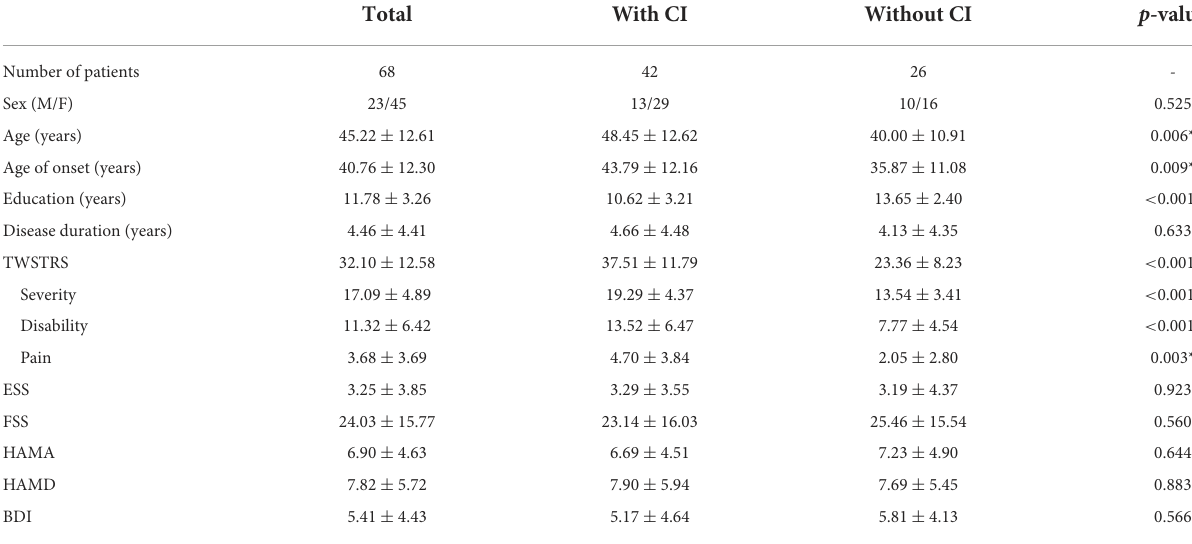
TABLE 3 Demographic and clinical data between CD patients with and without CI. Total With CI Without CI p -value Number of patients 68 42